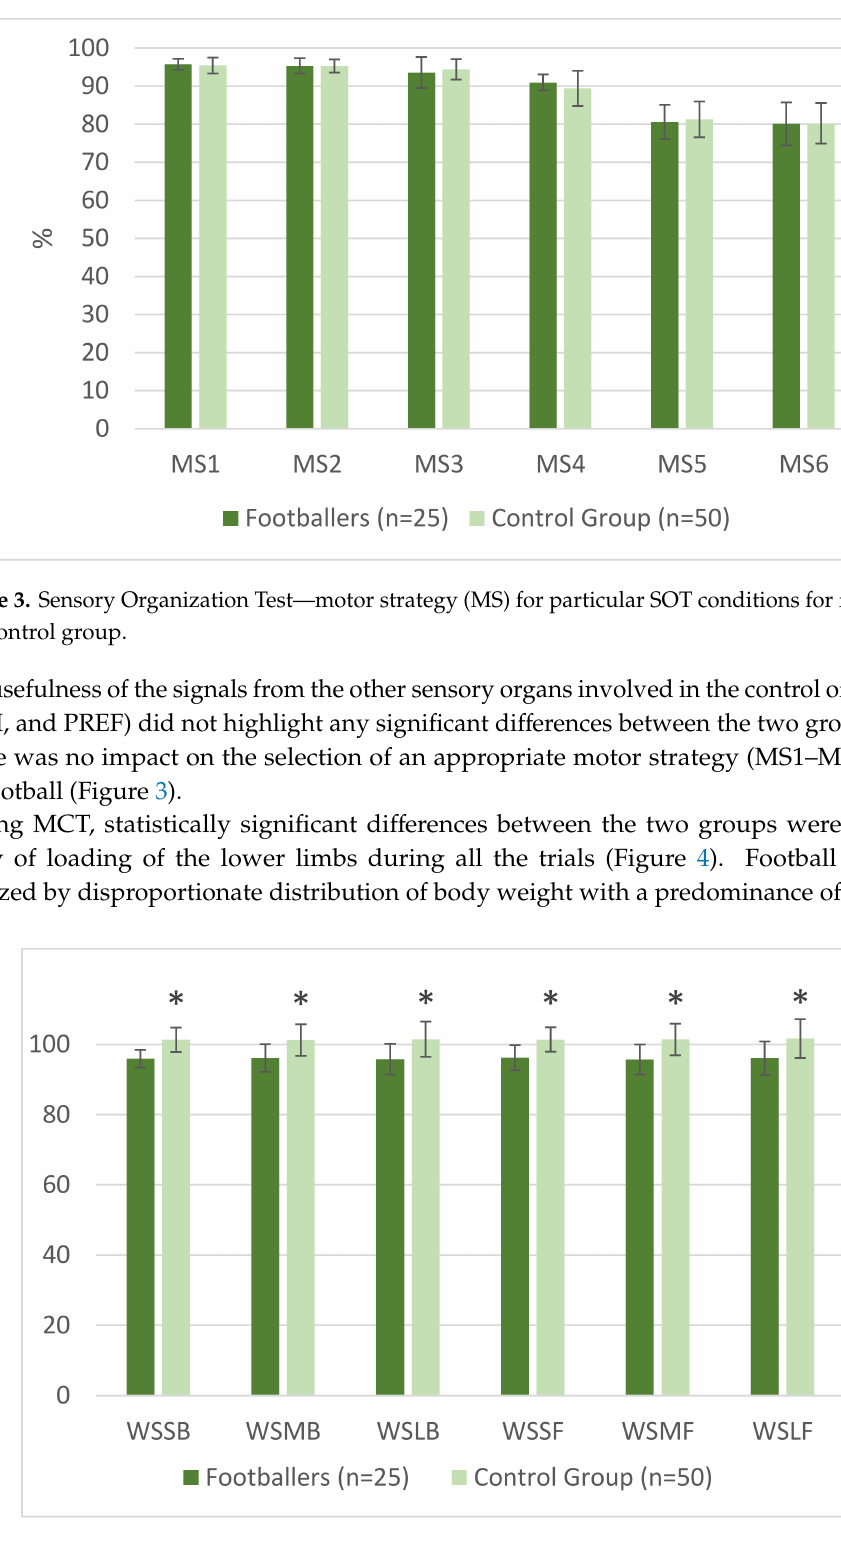
Figure 4. Motor Control Test—weight symmetry (WS) results for the lower limbs for small, medium and large platform transitions in backward (SB, MB, LB) and forward (SF, MF, LF) direction for footballers and control group. The symbol * refers to a significant di ff erence at p <